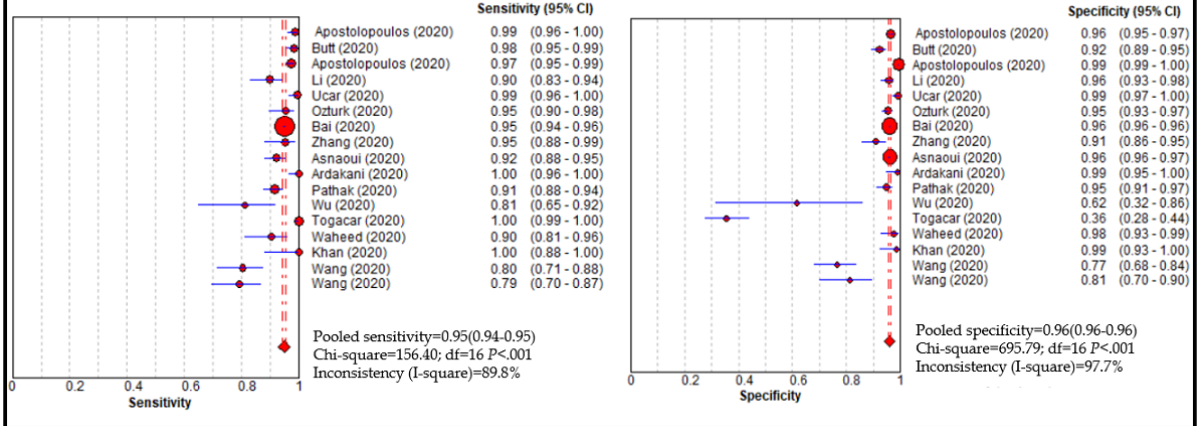
AccuracyAUROC a Negative likelihood